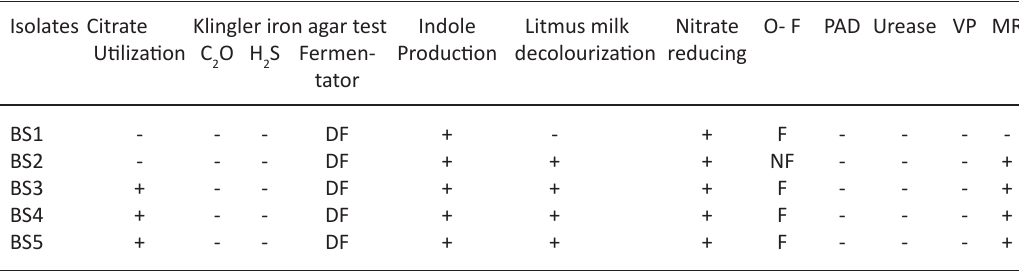
Table 1. Screening for Biochemical Characteristics of the endophytic isolates. Isolates Citrate